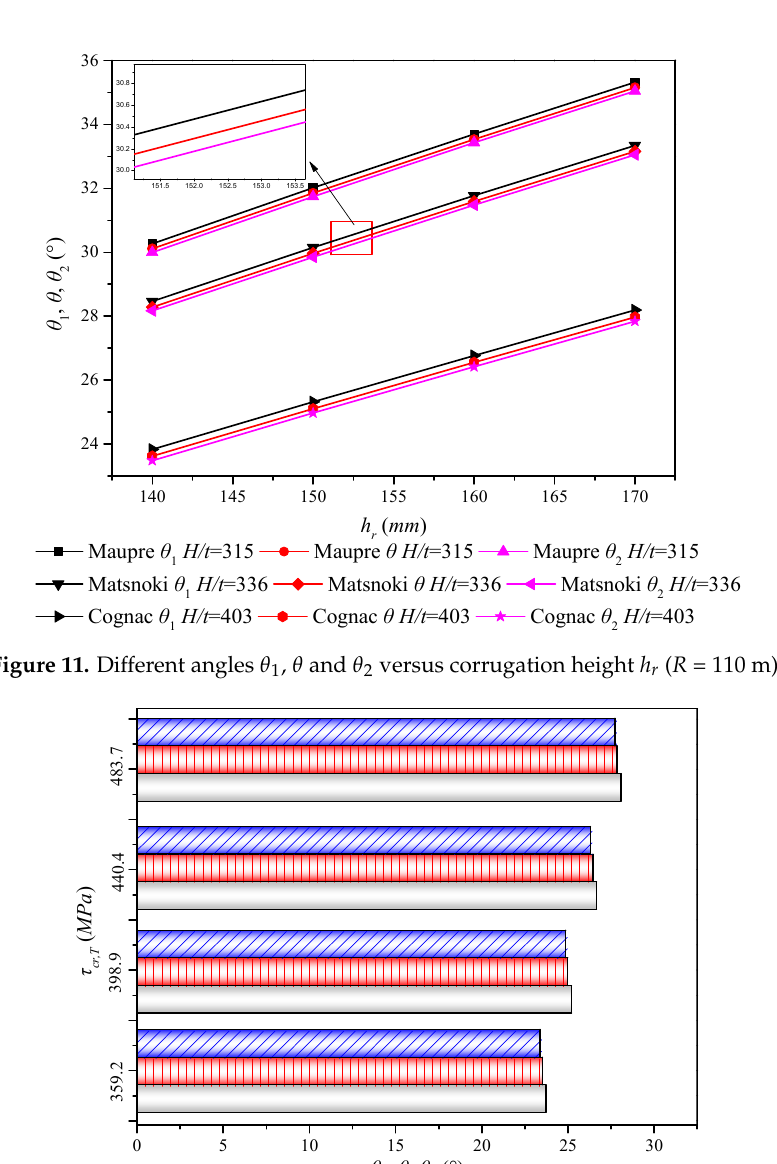
Figure 10. Global elastic shear buckling strength of PCCSW in theory τ cr,T versus corrugation height h r ( R = 110 m).